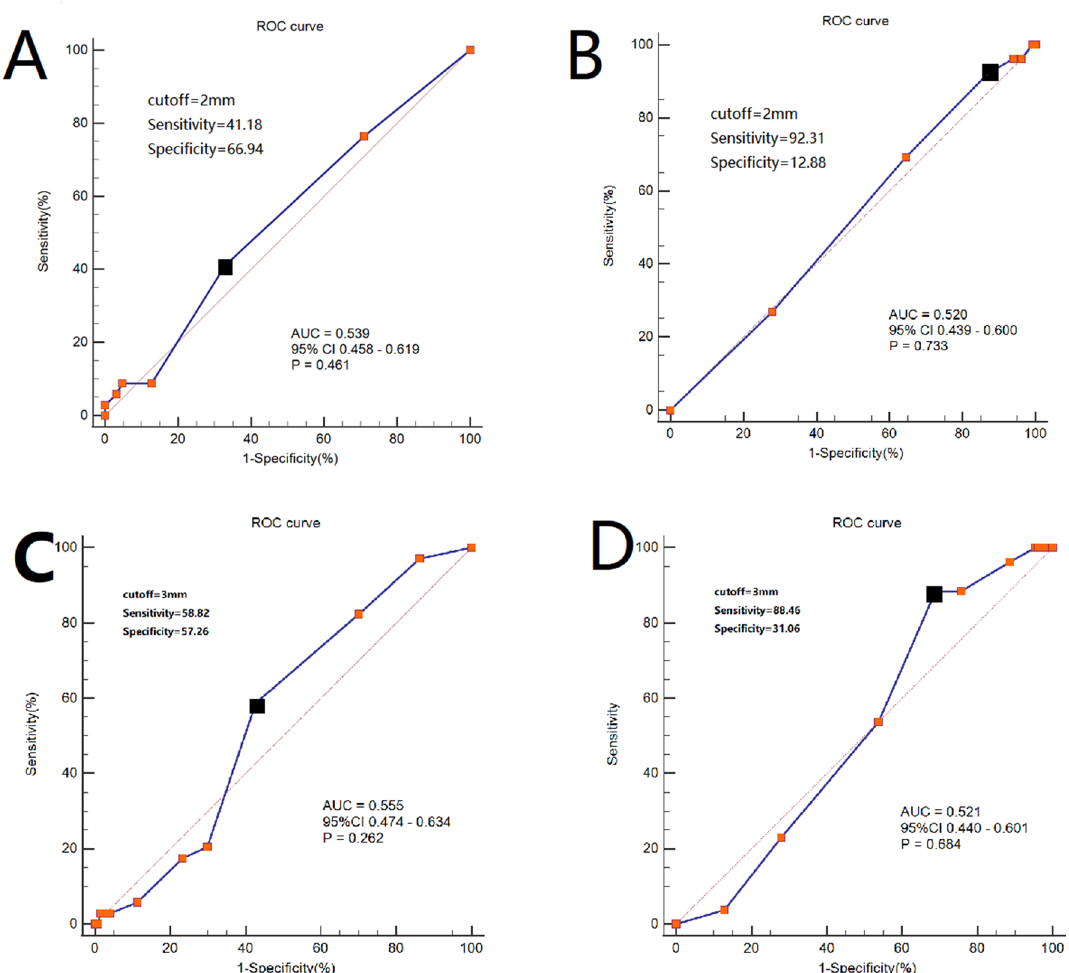
Figure 2. Receiver operating characteristics (ROC) analysis for the cutoffs of ENE for DFS and OS. ( A ) ROC curve of PD-ENE to predict DFS. ( B ) ROC curve of PD-ENE to predict OS. ( C ) ROC curve of CD-ENE to predict DFS. ( D ) ROC curve of CD-ENE to predict OS. The black dot indicated the optimal threshold. The area under the curve (AUC), 95% confidence interval (CI) and p -value were listed in the